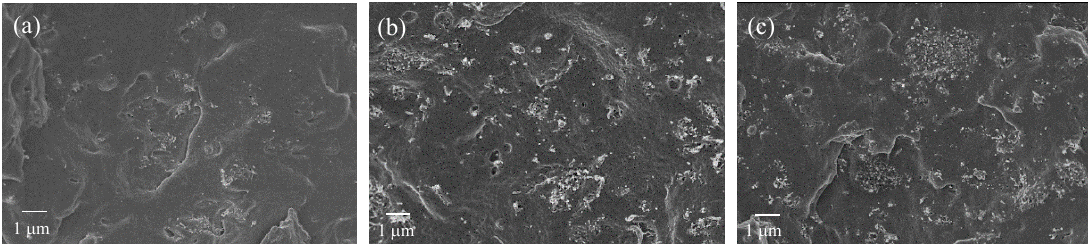
Figure 5. (a) Elastic modulus and (b) strain at failure as a function of CNTs wt% content